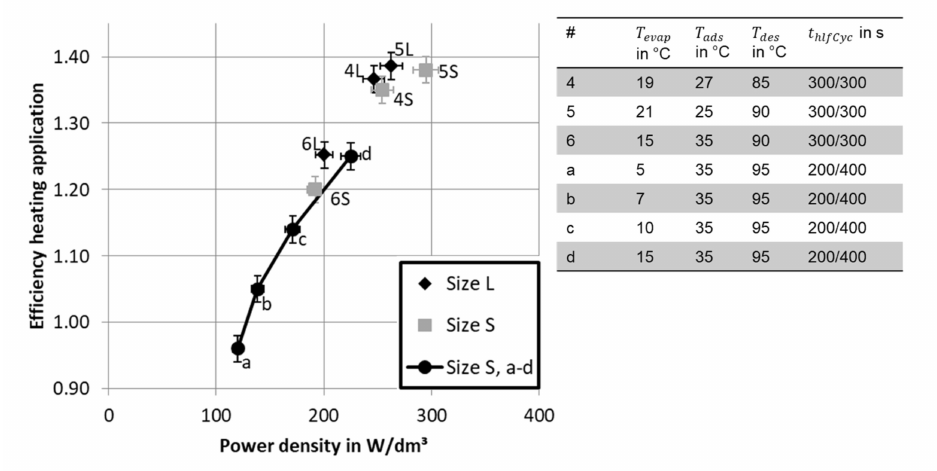
Figure 17. Efficiency and power density for the two different modules (Size S and Size L) for three different temperature conditions (points 4, 5, 6) and the data for Size S module for different evaporator temperatures as presented in Section 3.2.2.